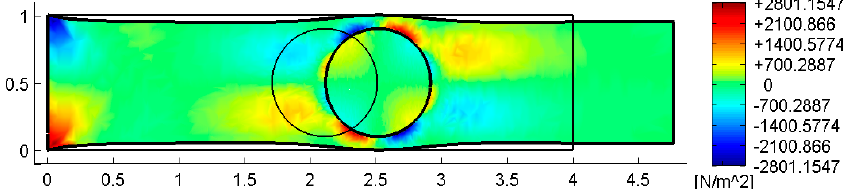
Figure 28. CM static analysis: shear stresses τ xy plotted on the deformed configuration (Thin line: undeformed configuration. Thick line: deformed configuration. Amplification factor of the displacements: k = 500 ) [5].